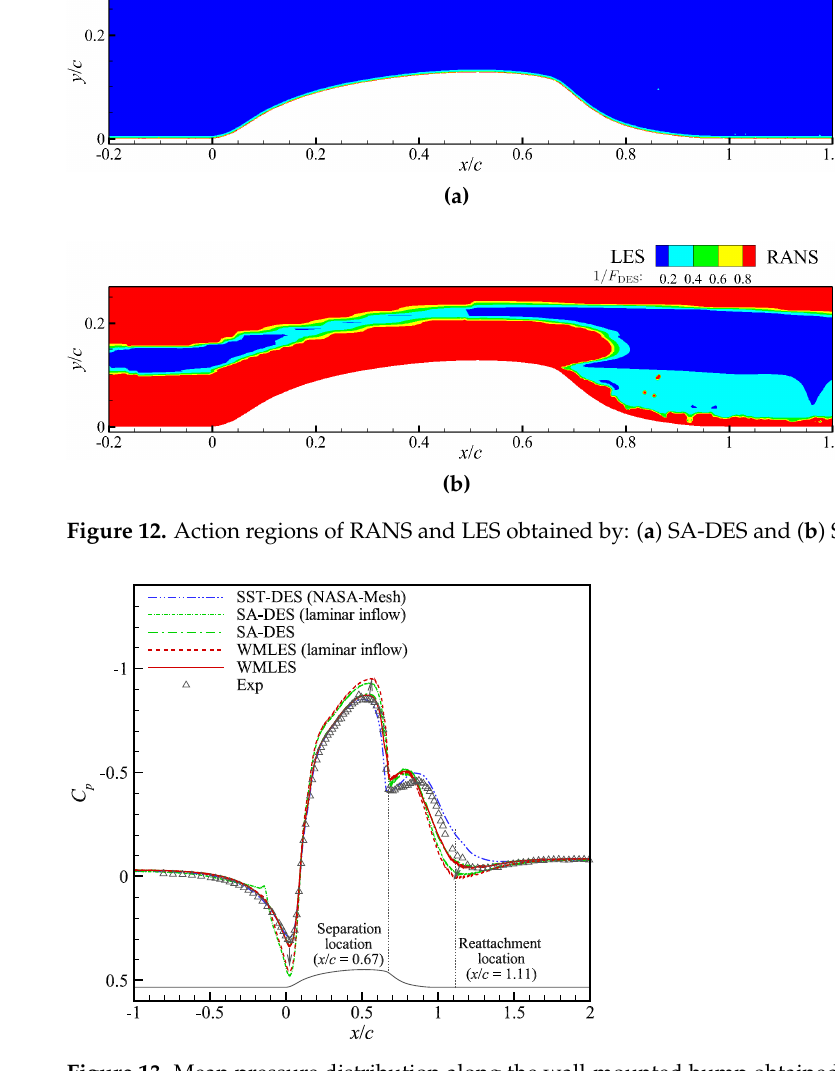
Figure 13. Mean pressure distribution along the wall-mounted hump obtained by DES and WMLES methods with/without turbulent inflow. Table 5. Separation and reattachment locations predicted by several numerical methods with turbulent